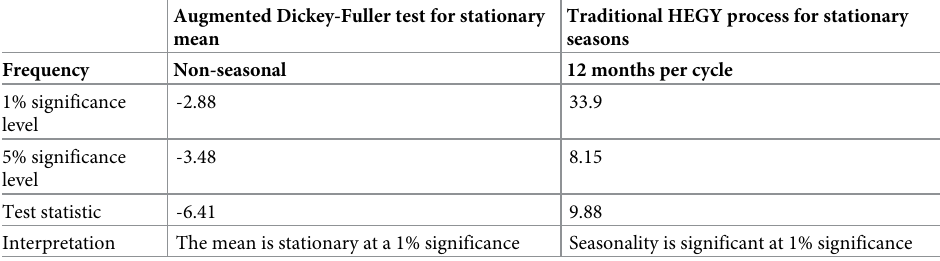
Table 1. Standard and seasonal unit root test results of the variable of the natural log-transformed monthly lepto- spirosis cases. Augmented Dickey-Fuller test for stationary